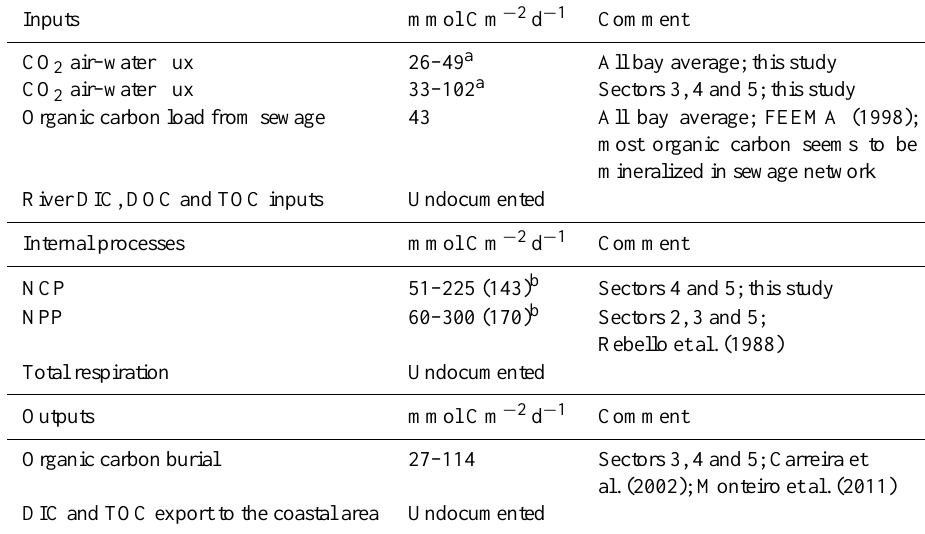
Table 3. Summary of the documented carbon fluxes in the Guanabara